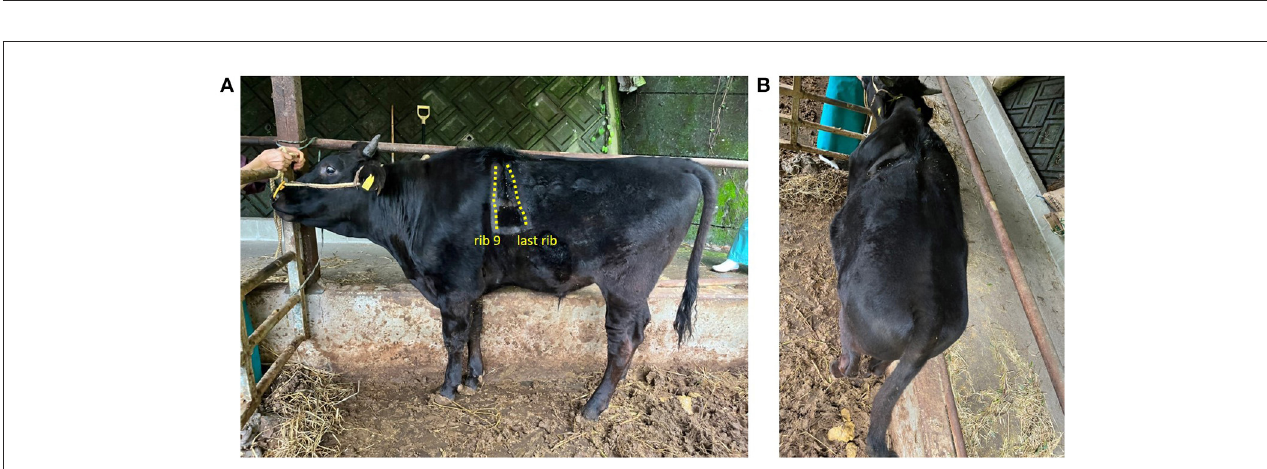
FIGURE4 Eleven months postoperatively calf’s age was 14 months. The dashed line area is the rib. The cranial dashed line indicates the 9th rib, and the caudal line indicates the last rib. (A) Left-sided and (B) dorsal